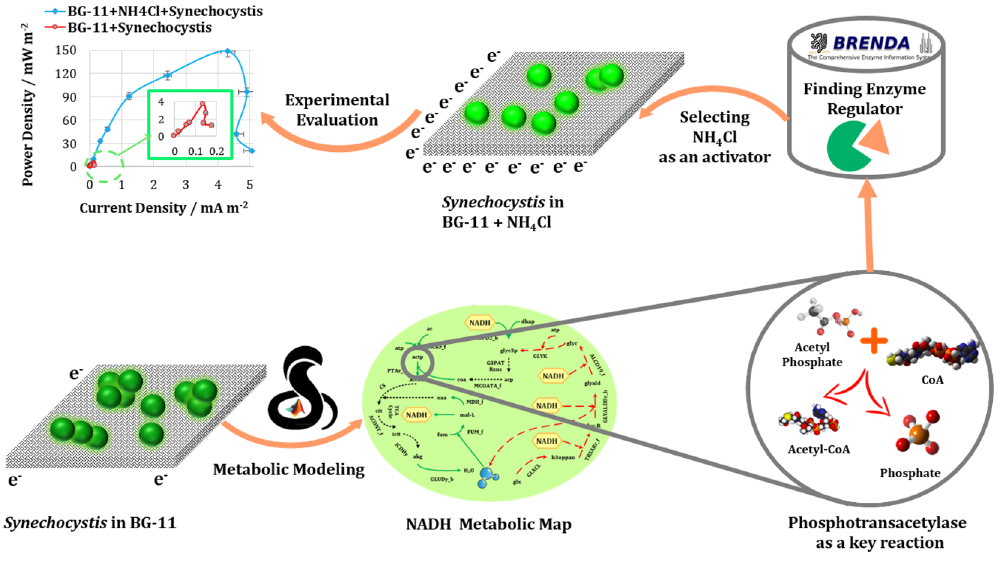
Figure 7. Graphical